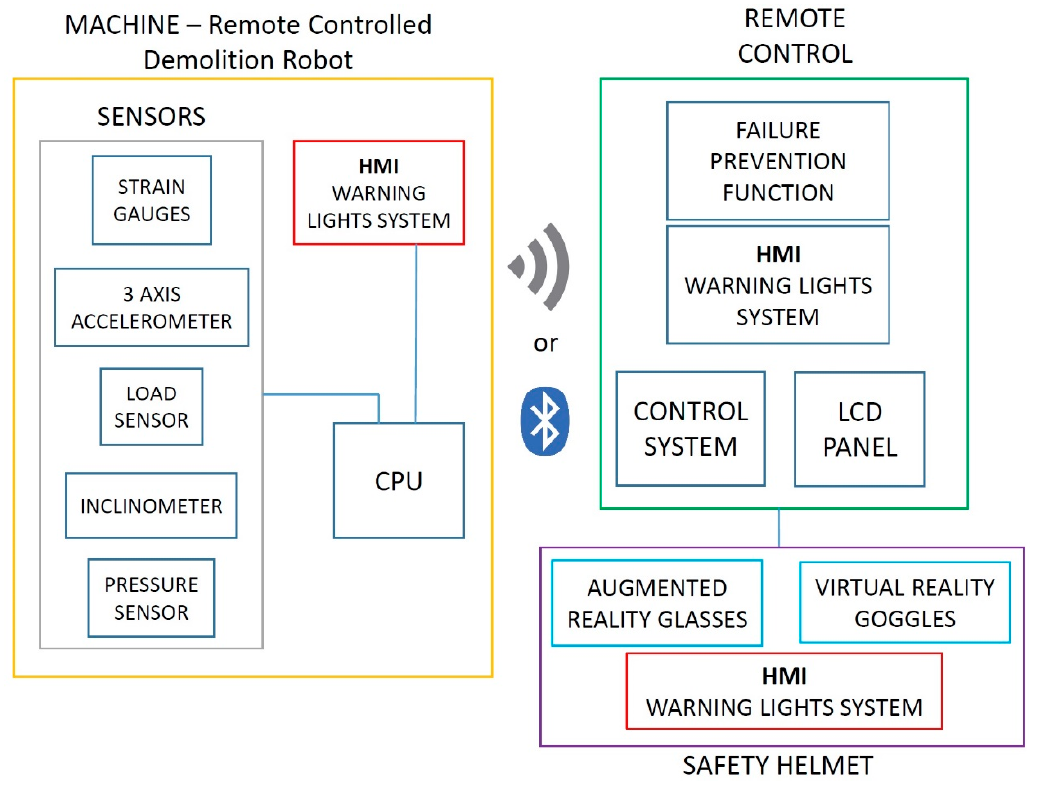
Figure 12. Block diagram of a Human–Machine Interface (HMI) accident prevention system.